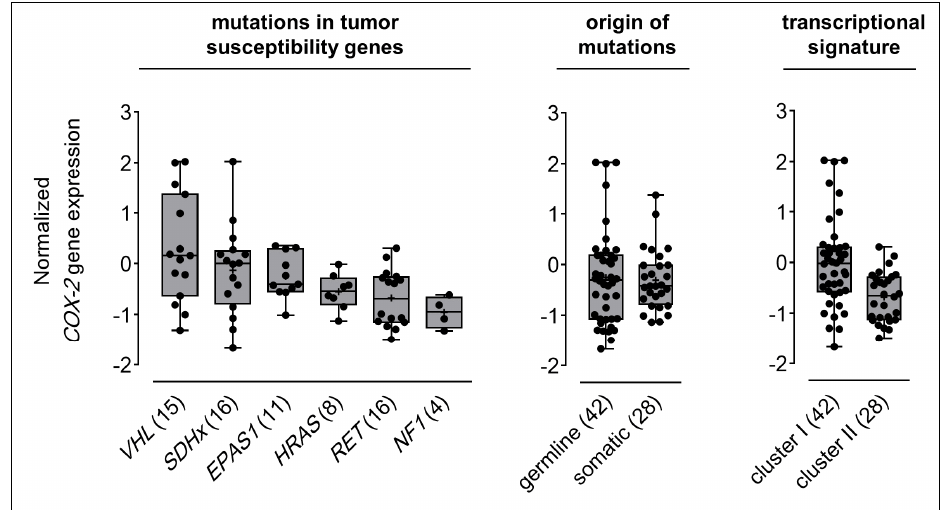
Figure 1. Normalized COX-2 gene expression in PPGLs with regard to genetic background. gene expression array data were derived from Lopez-Jimenez et al. [50] and Qin et al. [51] mRNA expression series. Seventy samples with known genotype were included in this analysis and classified according to the specific gene mutated, origin of mutations, and transcriptional cluster; numbers in parentheses represent the number of samples investigated in each subgroup; see Table S1 for statistical analyses.